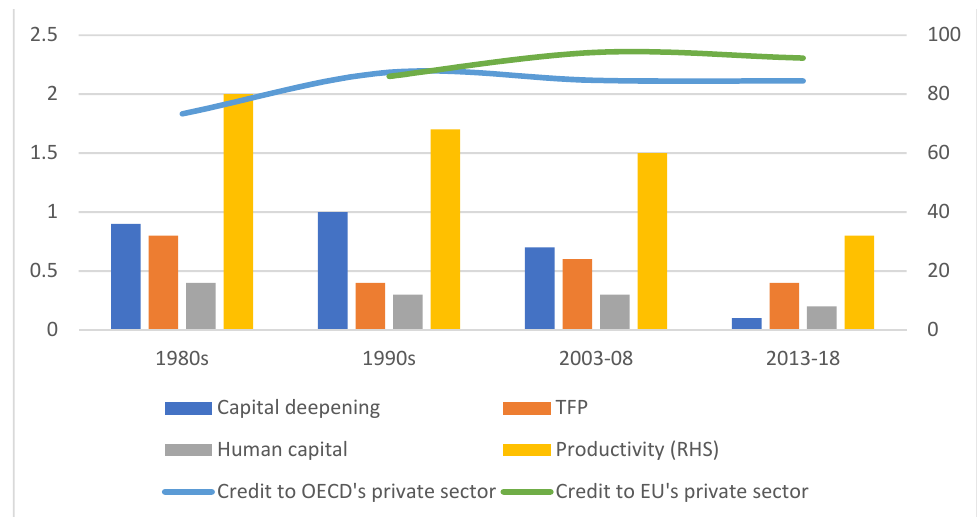
Figure 1. Contributions to productivity (left axis, %) and domestic credit flow to private sector by banks (right axis, GDP %). Note : contributions to productivity refers to advanced countries, such as OECD countries. Source : data are stemming from World Bank, World Development Indicators 2022.